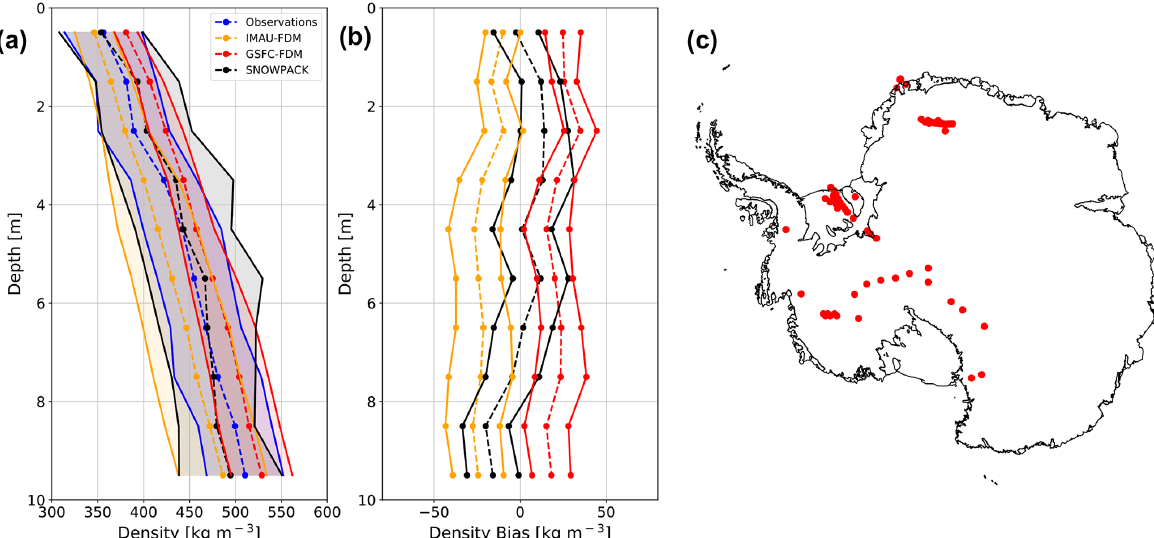
Figure 10. SNOWPACK, IMAU-FDM, and GSFC-FDM density simulations at sites not included in the IMAU-FDM and GSFC-FDM calibrations. Average observed (blue) and SNOWPACK-modeled (black), IMAU-FDM-modeled (yellow), and GSFC-FDM-modeled (red) near-surface (0–10m) density profiles at 69 sites not included in the IMAU-FDM and GSFC-FDM density calibrations (a) . Shading repre- sents plus and minus 1 standard deviation across 69 observed and modeled density profiles. Mean SNOWPACK (black dashed), IMAU-FDM (yellow), and GSFC-FDM (red dashed) density bias profiles at the 69 sites not included in the IMAU-FDM and GSFC-FDM density cal- ibrations (b) . Error bars represent 95% confidence intervals on the bias means. Map of 69 observed density profiles not included in the IMAU-FDM and GSFC-FDM density calibrations (c)